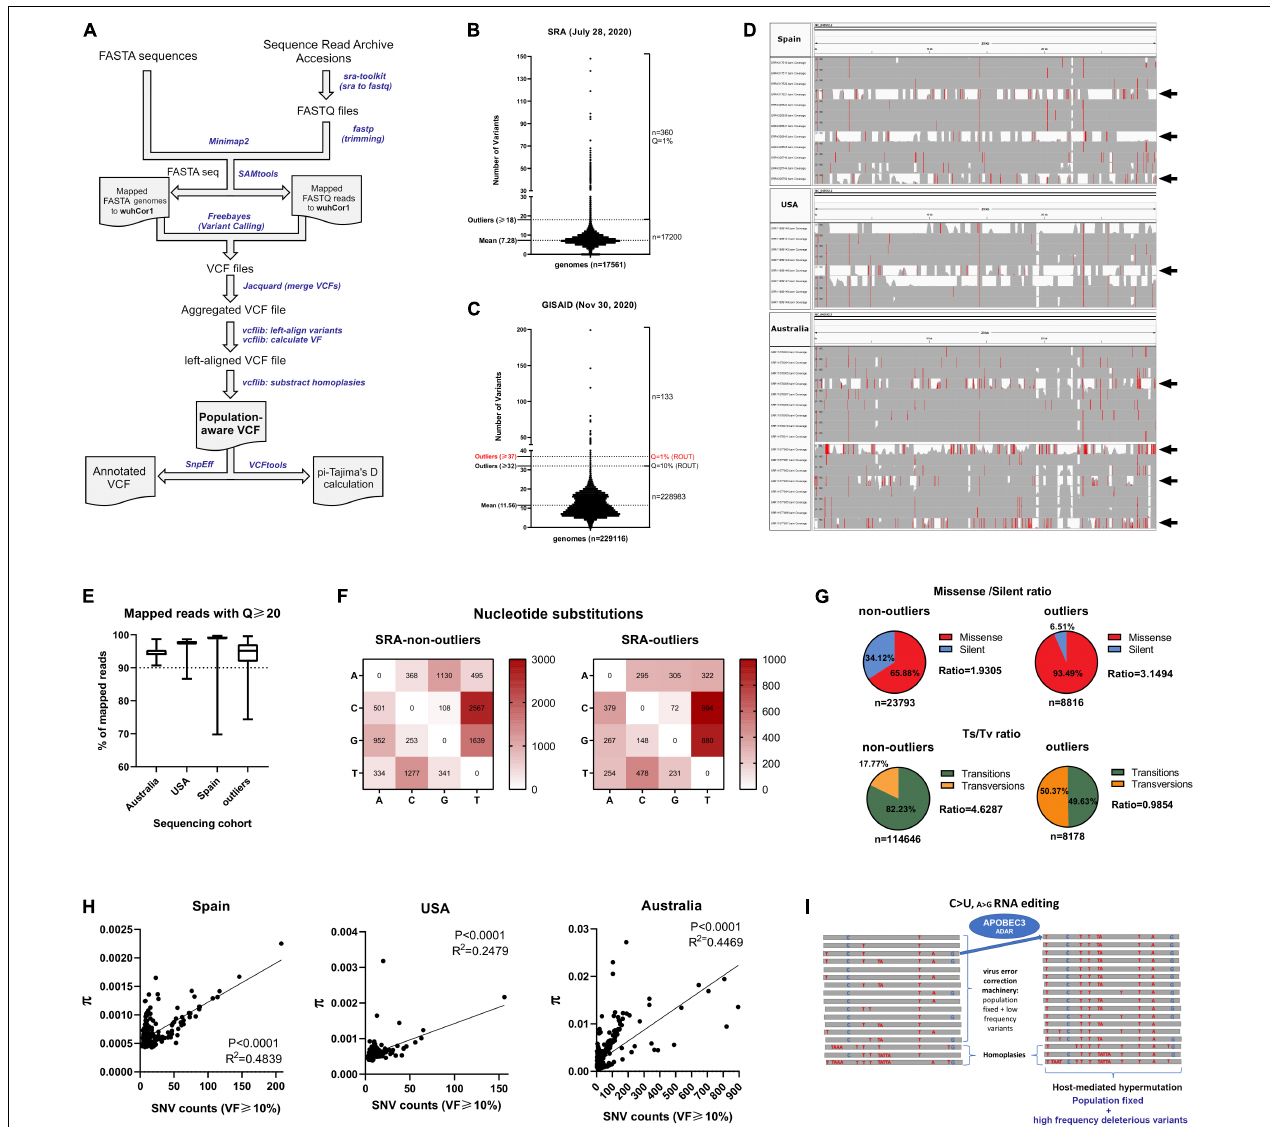
FIGURE 1 | SARS-CoV-2 genome analysis reveals inter-host diversity that in extreme cases leads to hypermutation. (A) Pipeline overview to process GISAID FASTA genome sequences and Sequence Read Archive datasets. Both inputs are aligned to SARS-CoV-2 reference genome (wuhCor1) and variant calling is performed to obtain a single population-aware VCF file suitable for downstream genetic analysis. Streamlined bioinformatic tools are depicted with blue letters. (B) Major viral frequency variants (via a consensus calling approach) for 17,560 next generation sequencing (NGS) datasets downloaded from SRA, separated by non-outliers ( n = 17,200) and outliers ( n = 360, Q = 1%, Grubbs’s test). Outlier number and mean of variants are depicted at left. (C) Same as B for 229,124 SARS-CoV-2 GISAID genomes, separated by non-outliers ( n = 228,093) and outliers ( n = 143, Q = 10%, Grubbs’s test). Outlier number and mean of variants are depicted at left. (D) IGV snapshots of outliers and non-outlier NGS samples from C. Outlier samples are depicted with black arrows, exceeding number of variants from non-outliers. Single nucleotide polymorphisms are depicted in red if nucleotide differs from the reference sequence by greater or equal to 50% of quality weighted reads. (E) Q20 statistics obtained with SeqKit program for mapped reads of 374 NGS datasets from Spain, 215 NGS datasets from United States, 397 NGS datasets from Australia and 360 outlier NGS datasets from SRA. Percentages are depicted in the y -axis. (F) Nucleotide change frequencies from 17,200 SRA NGS aggregated variants (non-outliers, left) and from 360 aggregated outlier variants (right), both annotated with SnpEff program. Frequency boxes are colored from white to dark red as number of changes increases. (G) (Upper) Pie charts depicting missense/silent ratios registered in the non-outliers and outlier NGS samples. Values are denoted as percentages and the total number of variants are denoted in the bottom of the graphs. (Lower) Same as upper, for transitions/transversions ratios (Ts/Tv). (H) Correlation between Average nucleotide diversity ( π ) provided by inStrain program and SNV counts (VF > 10%) for Spain ( n = 374, left), United States ( n = 215, middle) and Australian NGS samples ( n = 397, right). In the three countries, the two variables tend to increase together (see r -values of Spearman correlation analyses). (I) Proposed model of how APOBEC3G and ADAR complex (with minor contributions) can lead to hypermutation of SARS-CoV-2 (C > U and A > G editing) accompanied by intra-host diversity, homoplasies and increased transversions. In the majority of infections, it is probable that micro diversity is maintained at low frequencies due the action of the virus error correction machinery.